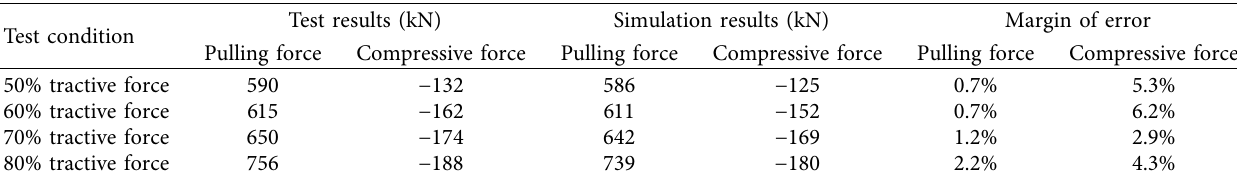
Figure 3: Time history of coupler force with 50% tractive force Table 5: Comparison between test results and simulation results.